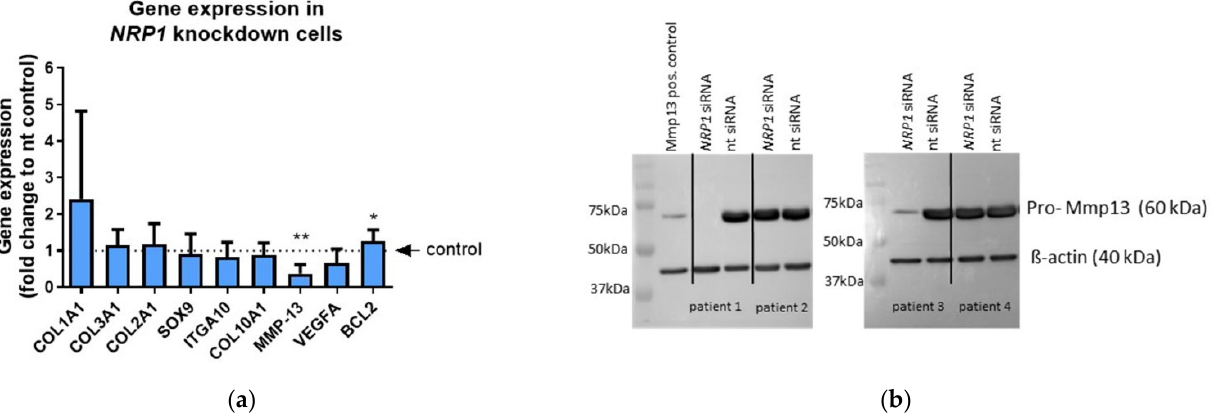
Figure 4. Gene expression of different marker genes and Mmp13 protein expression after NRP1 knockdown in OA chondrocytes. ( a ) Relative gene expression analysis in NRP1 knockdown cells in comparison with control (nt siRNA) cells. One sample t-test, n = 10, * p ≤ 0.05; ** p ≤ 0.01; ( b ) Western blot image of pro-Mmp13 and ß-actin protein expression of different OA-patients (n = 4) after transfection with NRP1 siRNA or nt siRNA.